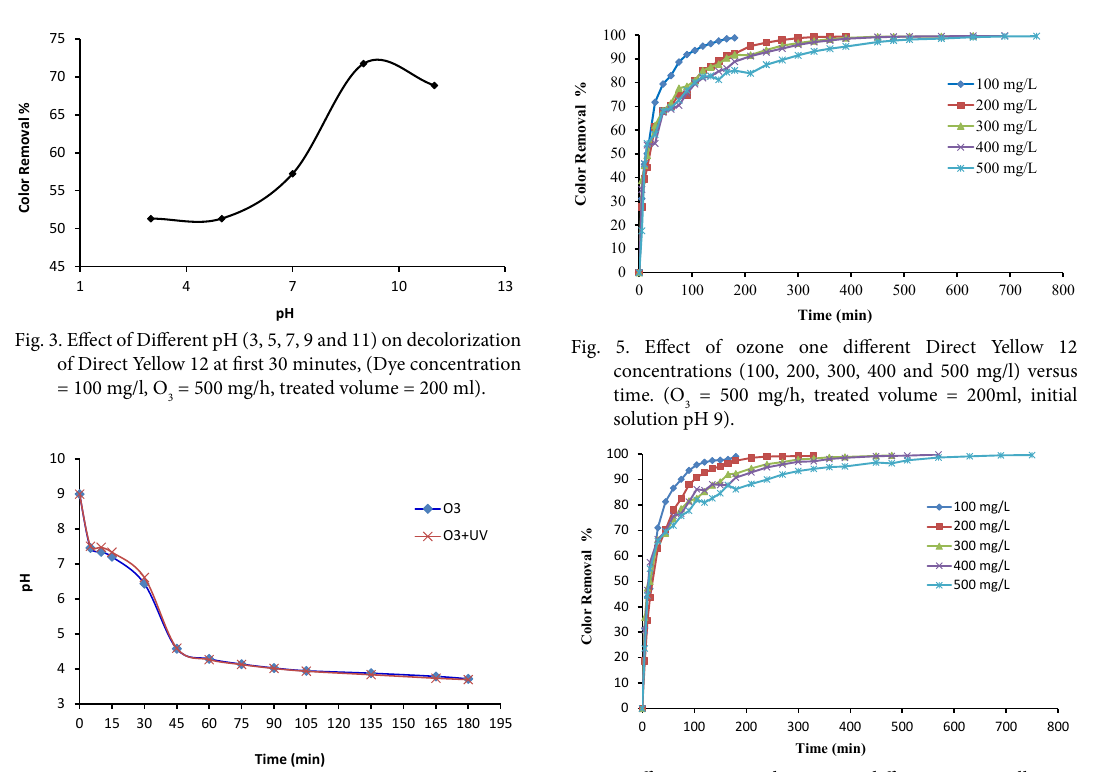
Fig. 6. Effect UV assisted ozone on different Direct Yellow 12 concentrations (100, 200, 300, 400 and 500 mg/l) versus time. Ozonation (O = 500 mg/h, treated volume = 200ml, 3 initial solution pH